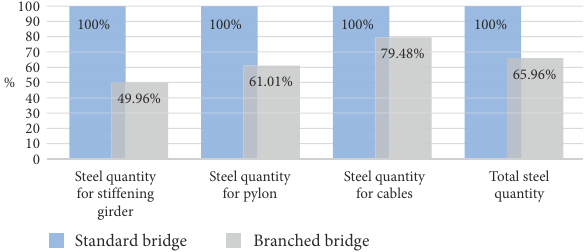
Figure 13. The results of the economic efficiency analysis. The blue colour indicates the standard bridge data, the grey colour – the branched bridge